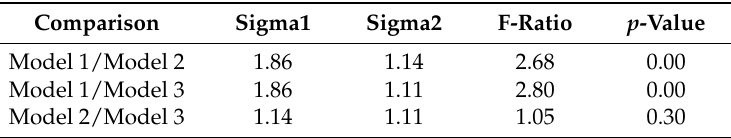
Table 3. Variance check.